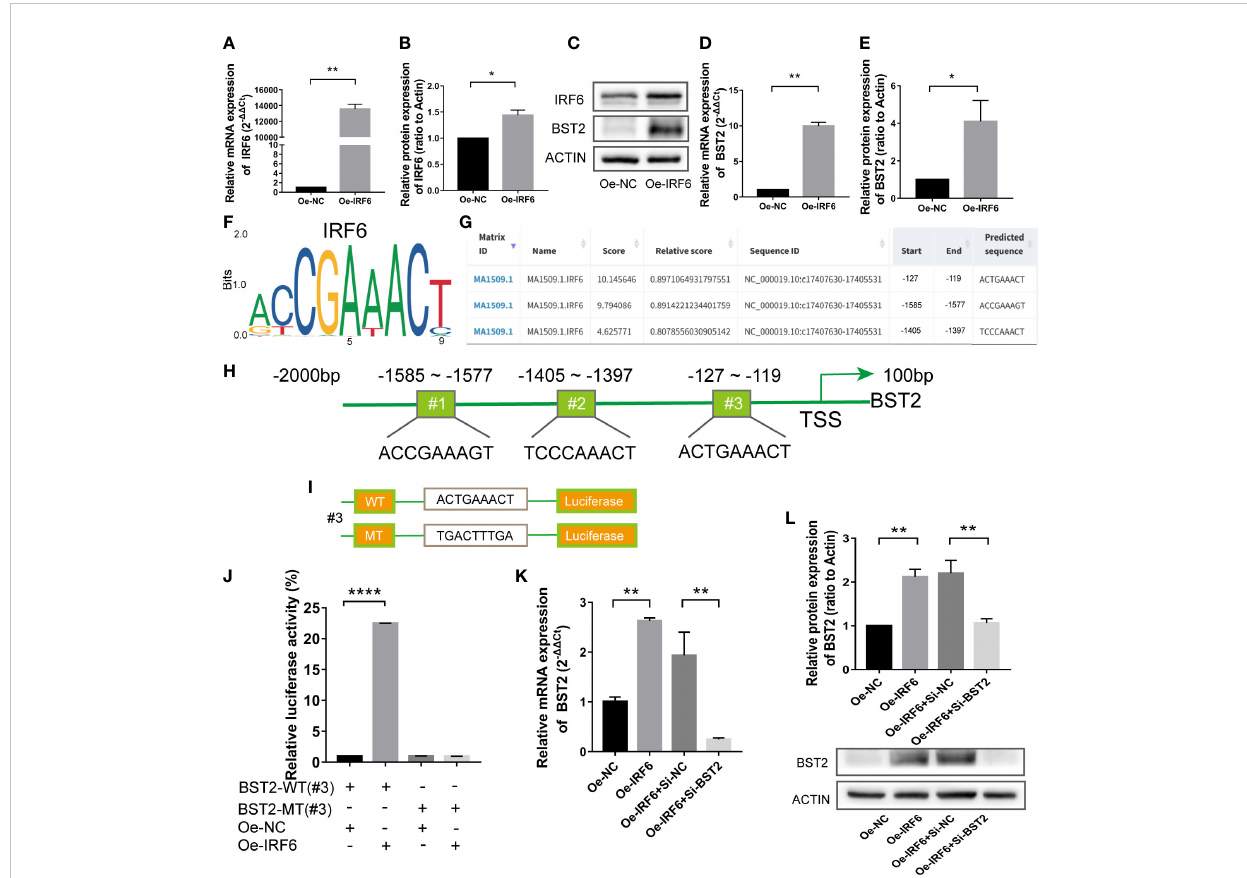
FIGURE 9 The transcription factor IRF6 directly binds to the promoter of BST2. (A, B) , The identi fi cation of the transfection ef fi ciency of Oe-IRF6 at the mRNA (A) and protein (B) levels. (C – E) , The BST2 expression by the qRT-PCR (D) and western blot assay (C, E) after transfection with Oe-IRF6 for 48h. (F) , The IRF6 binding motif. (G) , JASPAR predicted the binding sites of IRF6 and BST2. (H) , The illustrative model of the binding sites of IRF6 and BST2. (I) , The illustrative model of the wild or mutant binding sites. (J) , The dual-luciferase reporter assay was performed to examine the transcriptional activity of the BST2 promoter. (K, L) , The expression of BST2 were detected by the qRT-PCR (K) and western blot experiment (L) after overexpression IRF6 and/or knockdown BST2. *p < 0.05; **p < 0.01; ****p <